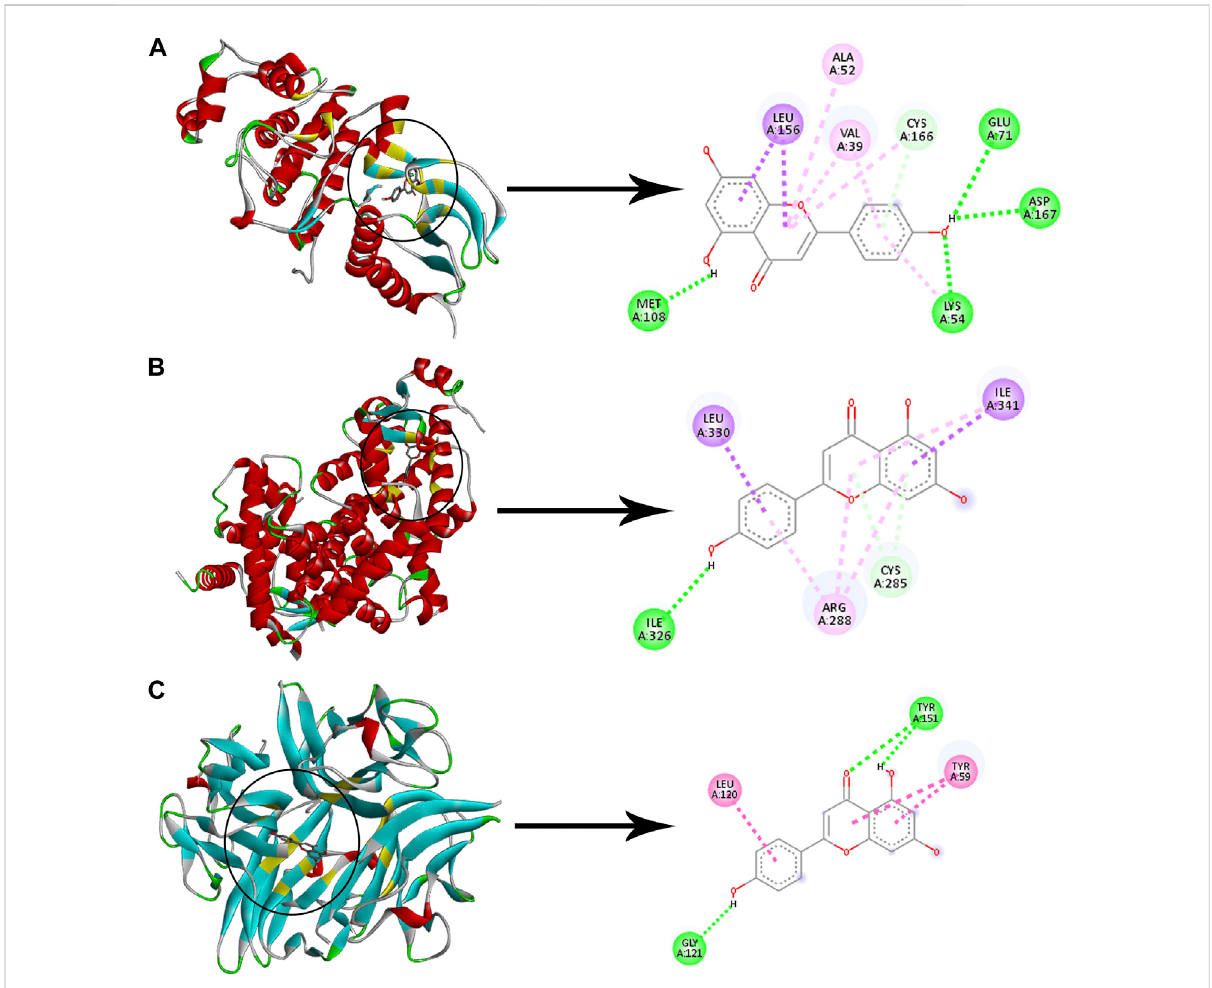
FIGURE 10 Molecular dockingofapigenin withthreeproteins.Theleftimagesand therightimagesrepresentthe3Dandthe2Dstructures,respectively (A) Docking of apigenin with MAPK1. (B) Docking of apigenin with PPARG. (C) Docking of apigenin with TNF. Adjusting the size of the images and resolution, adding the panels ’ letters, and combining the images was carried out using